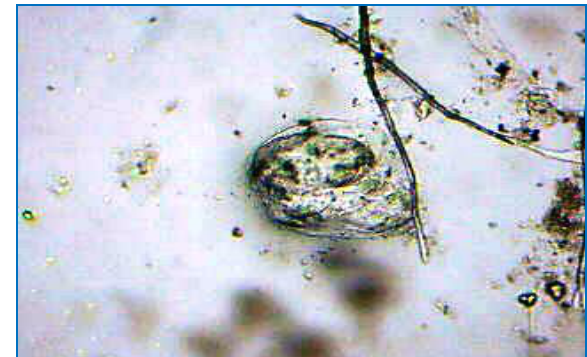
Figure, f: Strongyloides sp. egg in stray